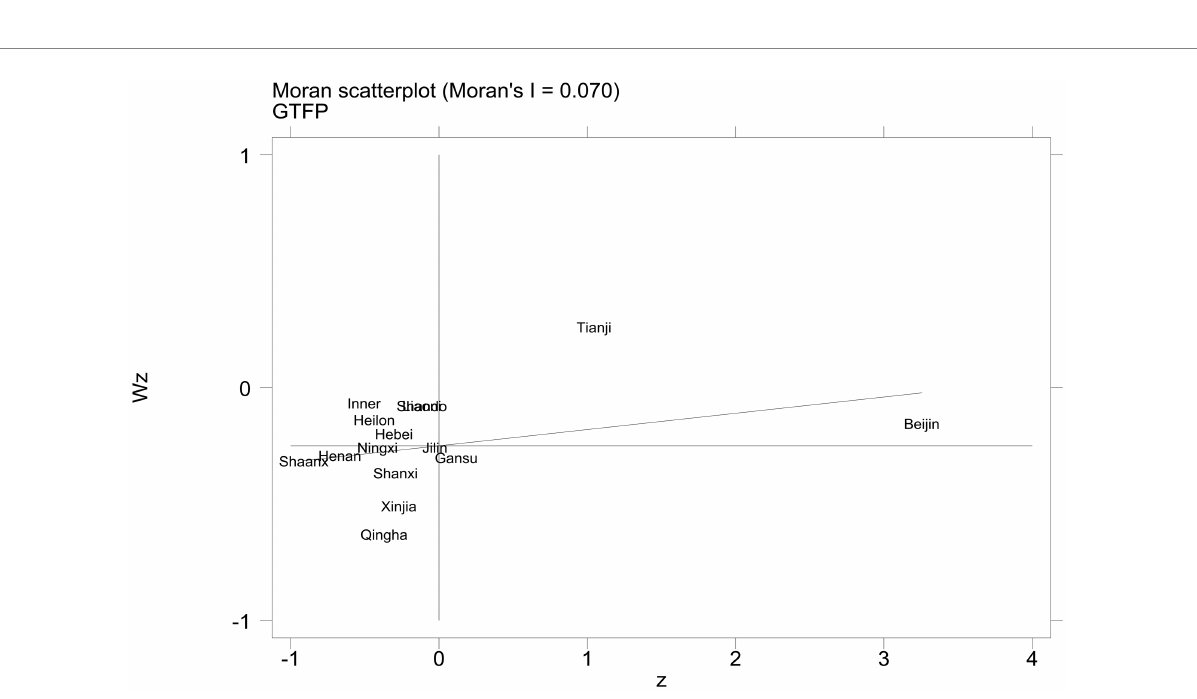
FIGURE 4 Distribution of the Moran index in northern